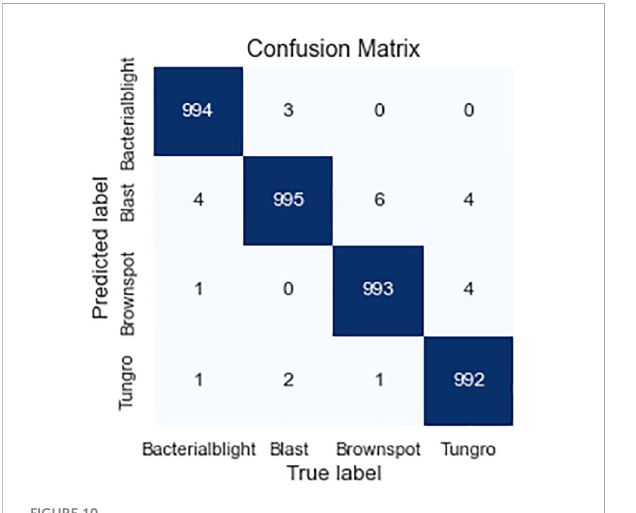
FIGURE 10 GAN-MSDB-ResNet confusion